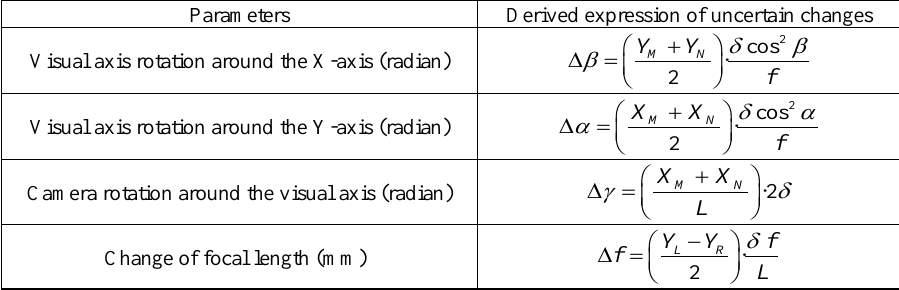
Table 2. Expressions of parameters